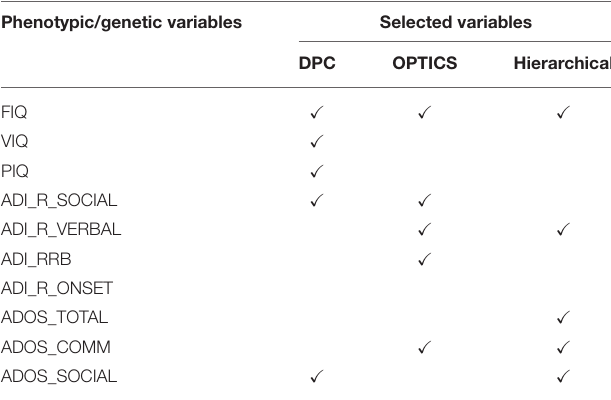
TABLE 3 | Phenotypic variables selected by GA with different clustering methods (ASD). Phenotypic/genetic variables